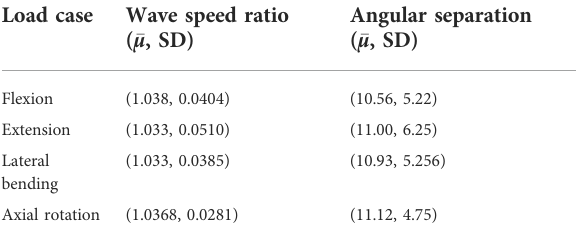
TABLE 2 Comparing theoretical and approximated (P-) wave speed